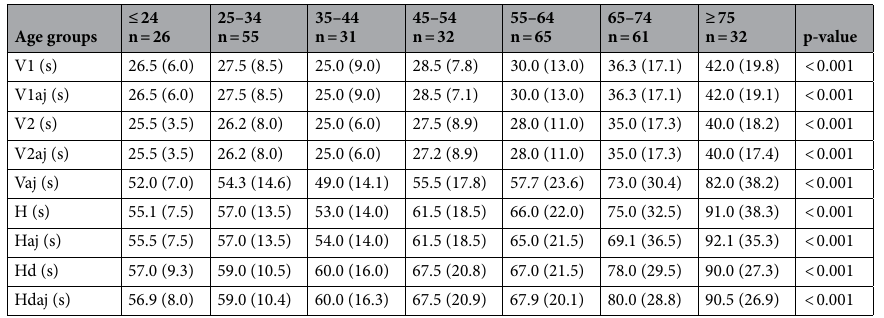
Table 2. Results of the ADEMd test in different age subgroups. The median and the interquartile range is displayed for each subgroup and each parameter as well as the p-value obtained of the global comparison among age subgroups. a Data are presented as median (IQR), or p values where indicated. H horizontal time, Haj horizontal adjusted time, Hd horizontal distractor time, Hdaj horizontal distractor adjusted time, Vaj vertical adjusted time, V1 first vertical sheet time, V1aj first vertical sheet adjusted time, V2 second vertical sheet time, V2aj second vertical sheet adjusted